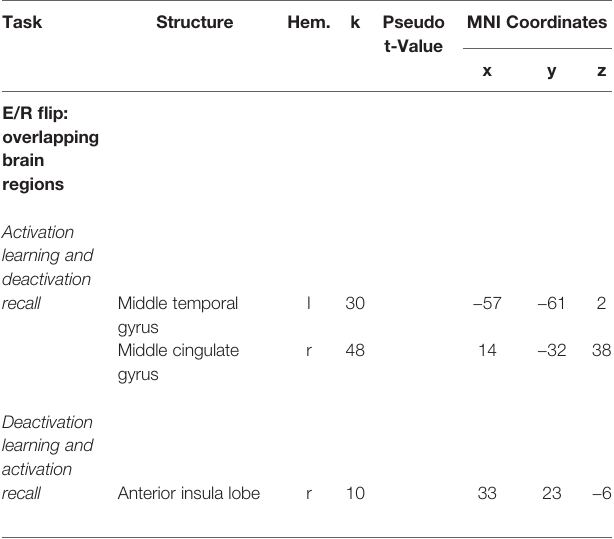
TABLE 2 | Overlapping regions of antagonistic activation (activation and deactivation) during mnemonic encoding and recall [i.e., regions forming an encoding/retrieval (E/R) fl